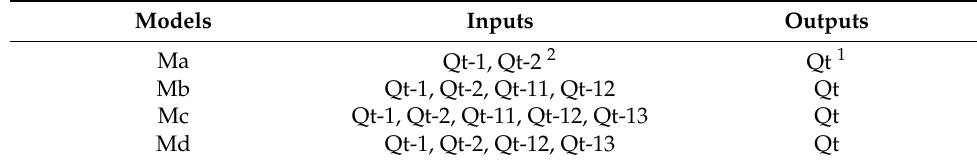
Table 2. Different input combinations to forecast future streamflow.